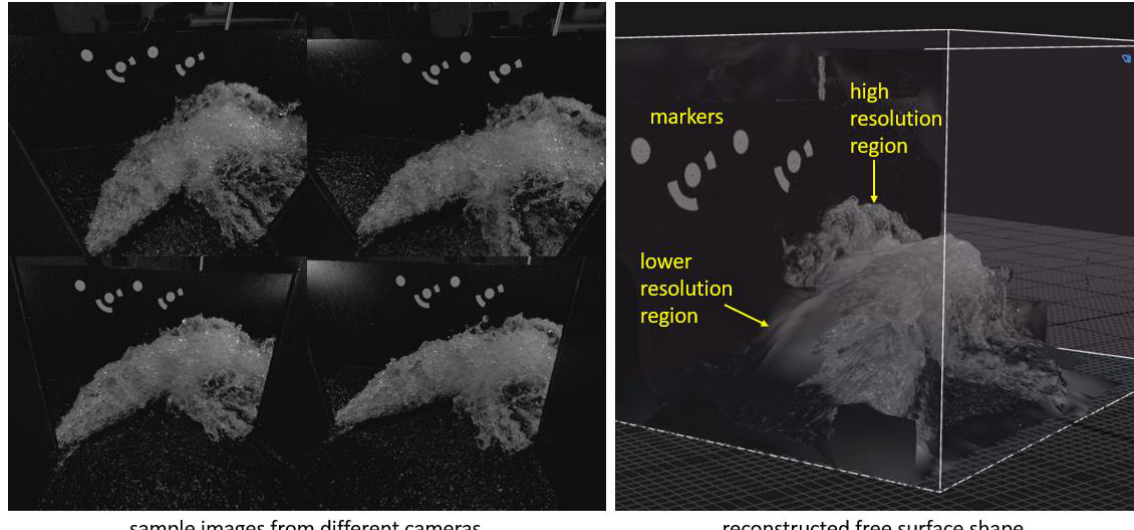
Figure 5. 3D free-surface shape reconstruction from partly overlapping 2D images.